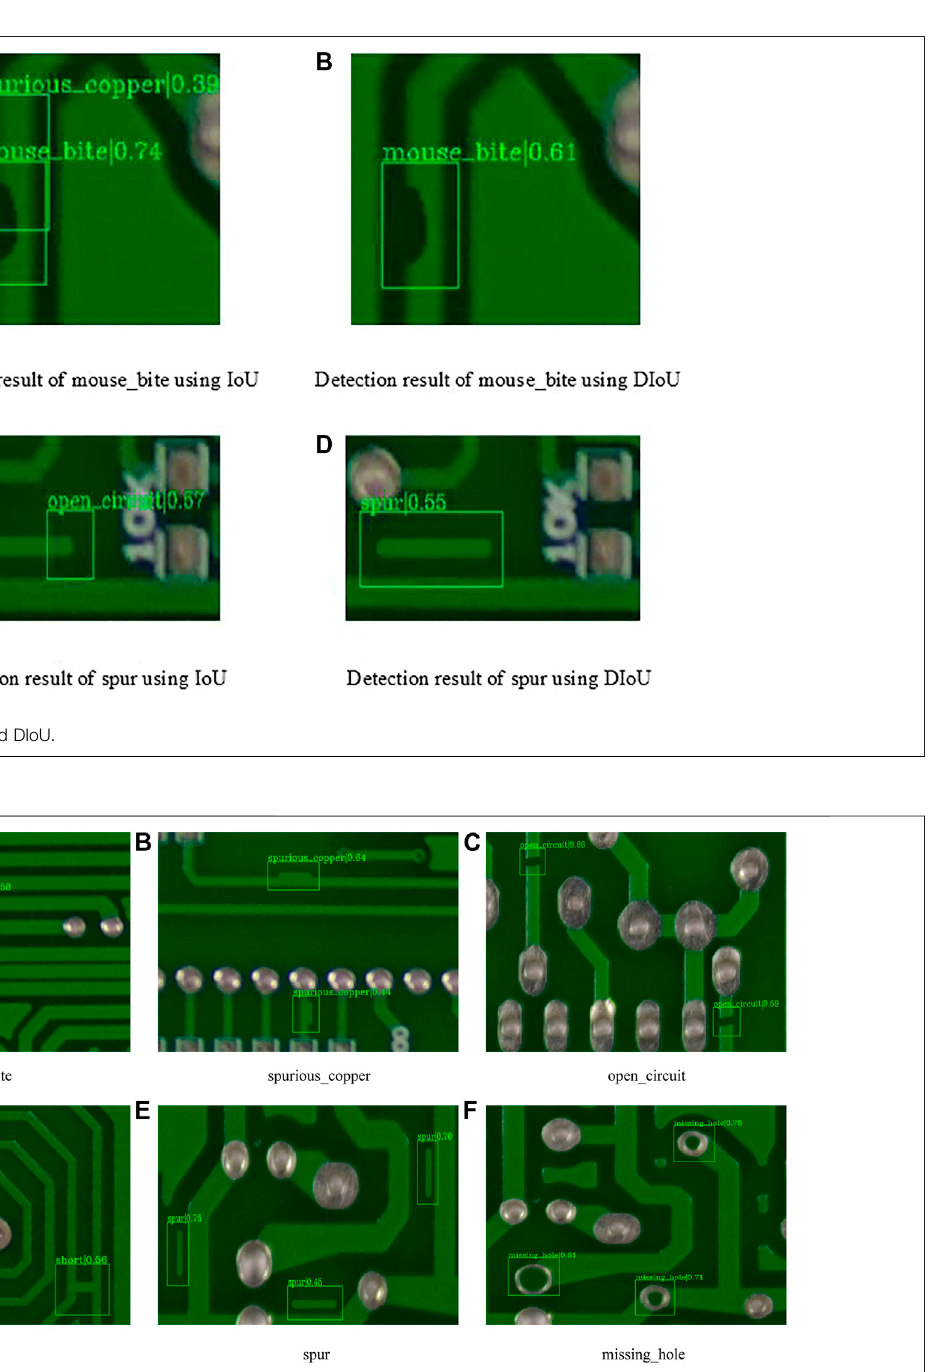
Figure 9 , Using the DIoU loss function can better mark the position of the detection bounding box, avoiding problems such as false detection and overlapping bounding boxes.